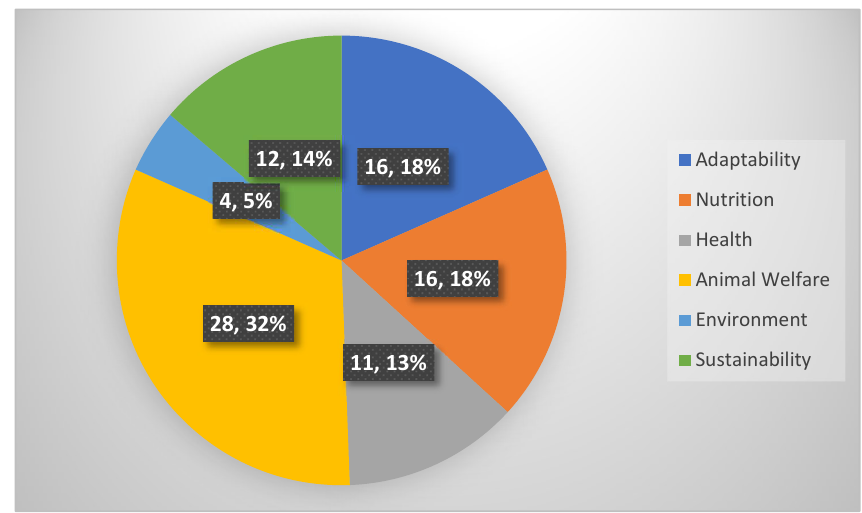
Figure 3. Distribution of revised studies per topic ( n and %).